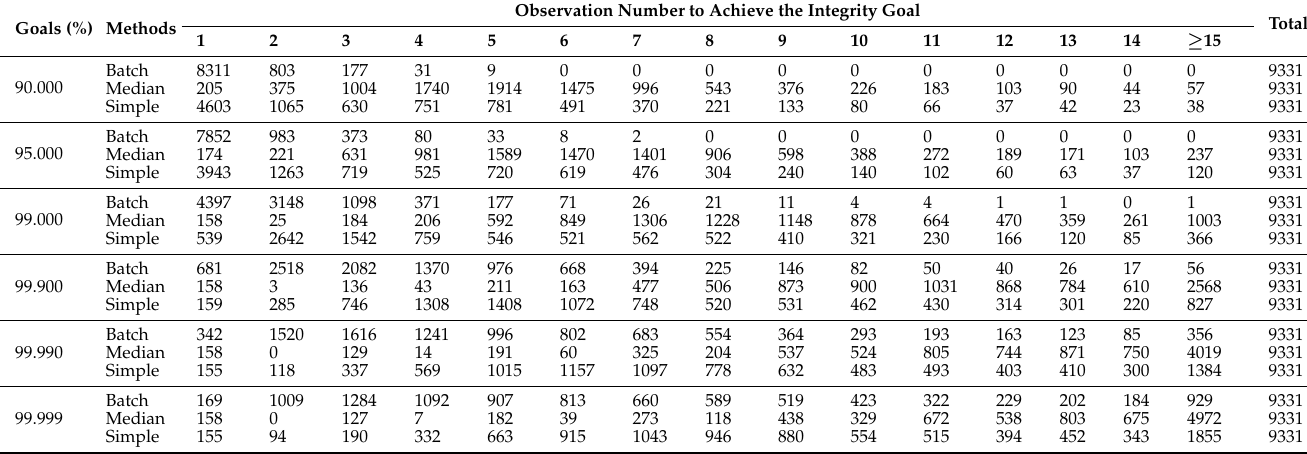
Table A2. Compositing results of six integrity goals using three different